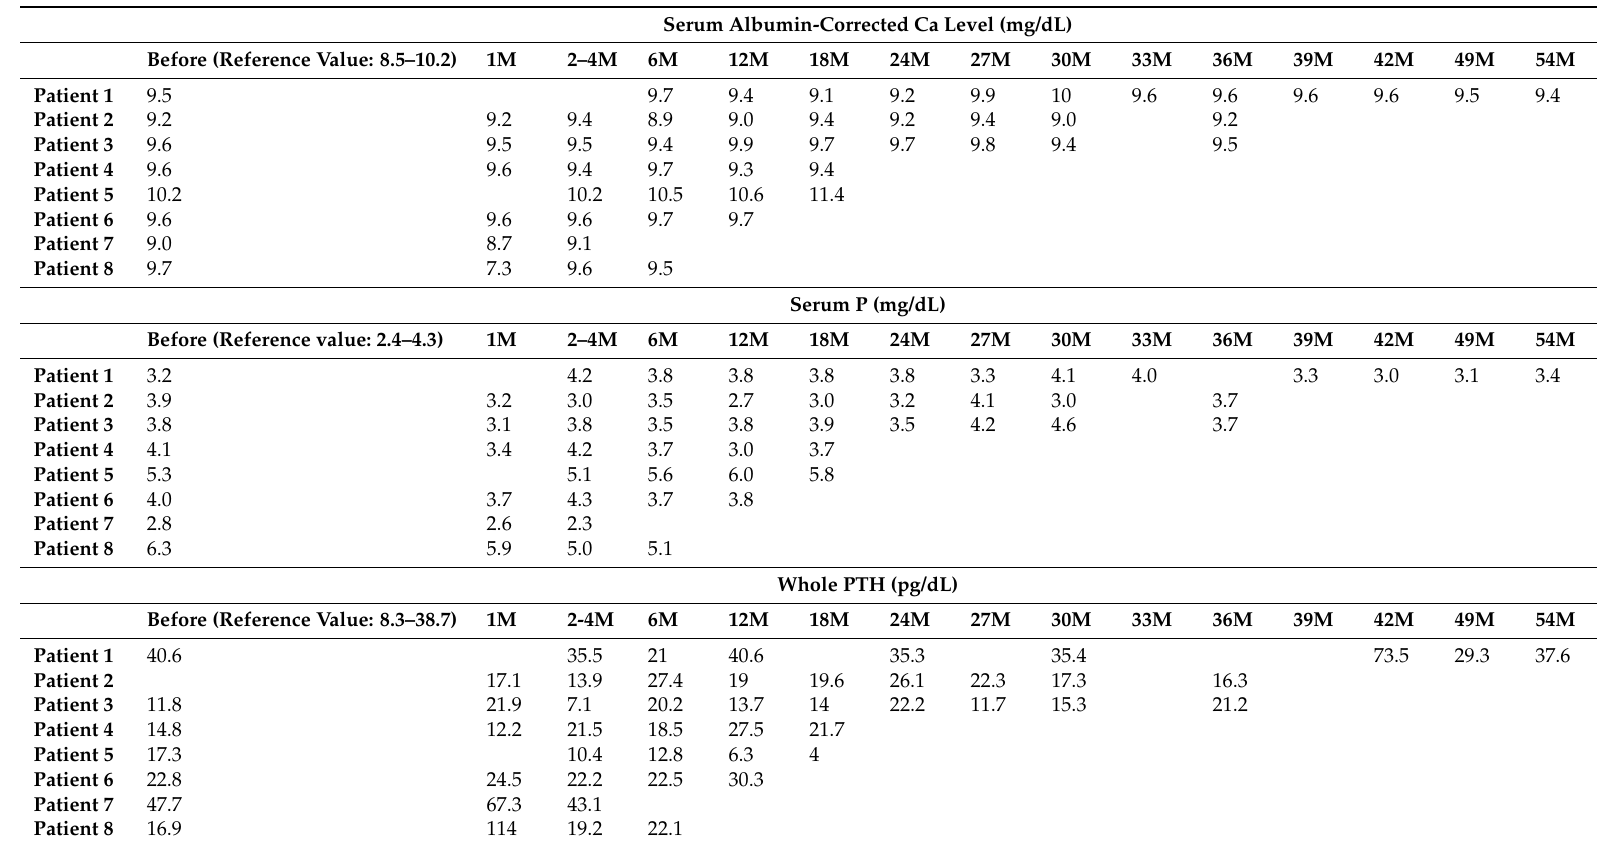
Table 2. Patient laboratory data across observation periods for each